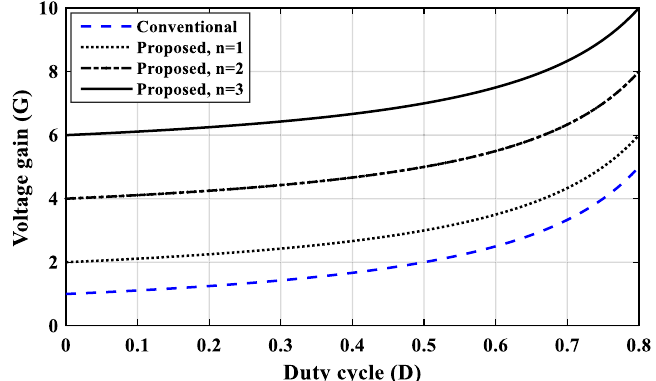
Figure 6. Voltage gain of the proposed boost converter at different number of cells ( n = 1, 2 and 3) and the conventional